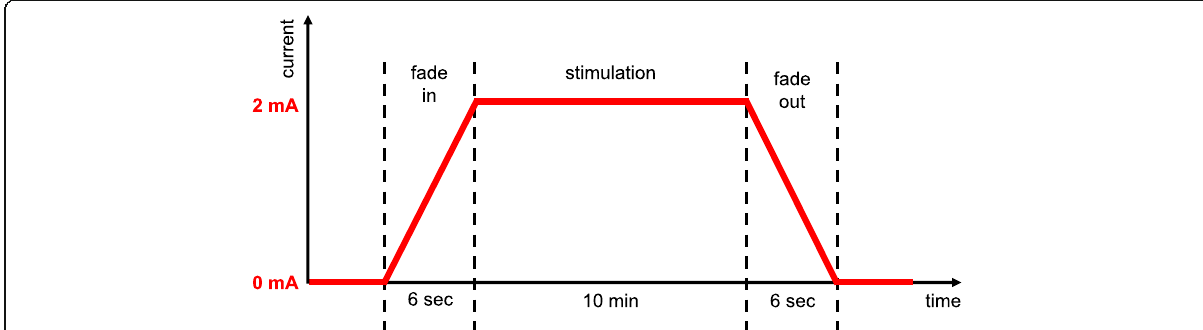
Fig. 2 Current flow in anodal tDCS (verum stimulation). After a fade-in phase of 6 s, anodal tDCS is applied at an intensity of 2 mA for 10 min, ending in a fade-out phase of again 6